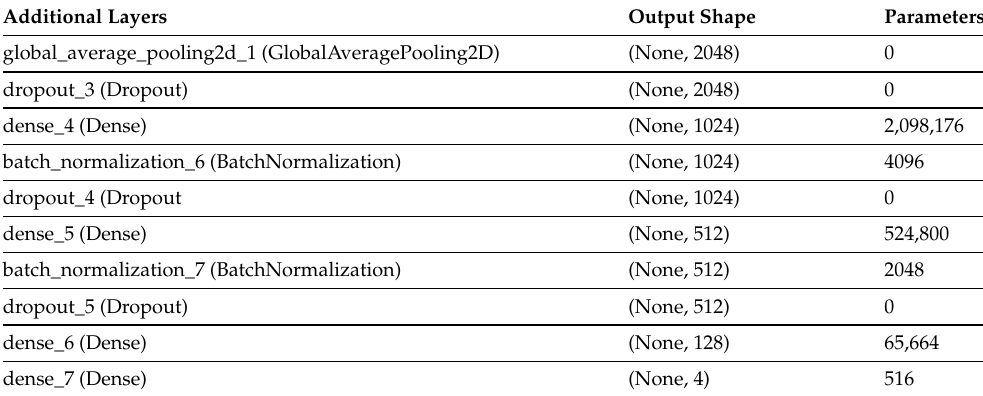
Table 2. This table describes the output shape and parameters of the additional layers of the pro- posed